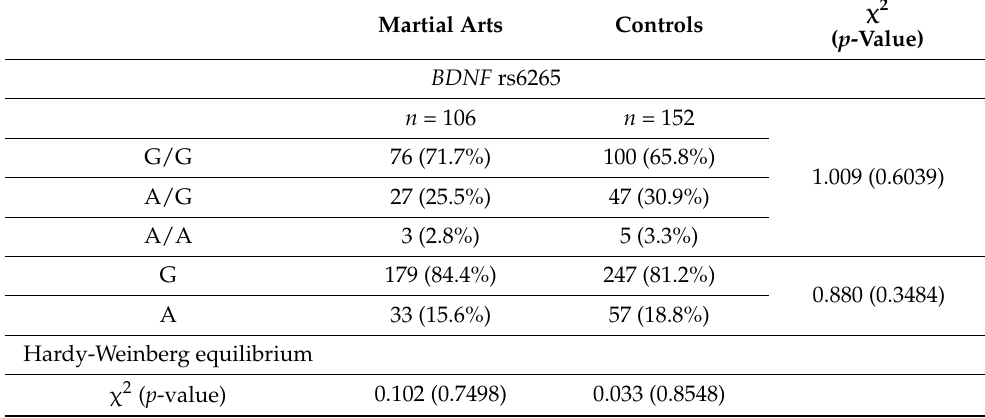
Table 1. Frequency of genotypes and alleles of the BDNF rs6265 in a group of martial arts subjects and controls.